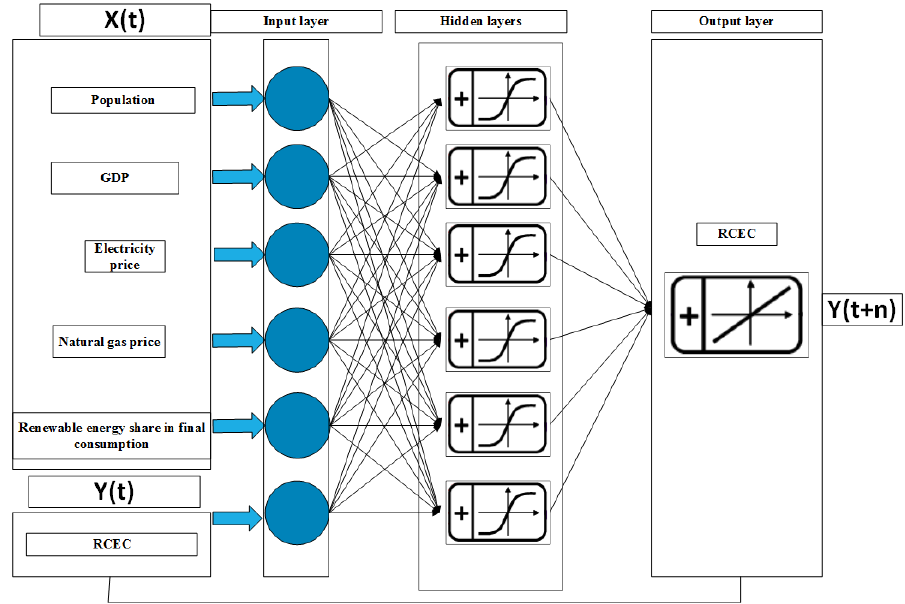
Figure 10. NARX ANN